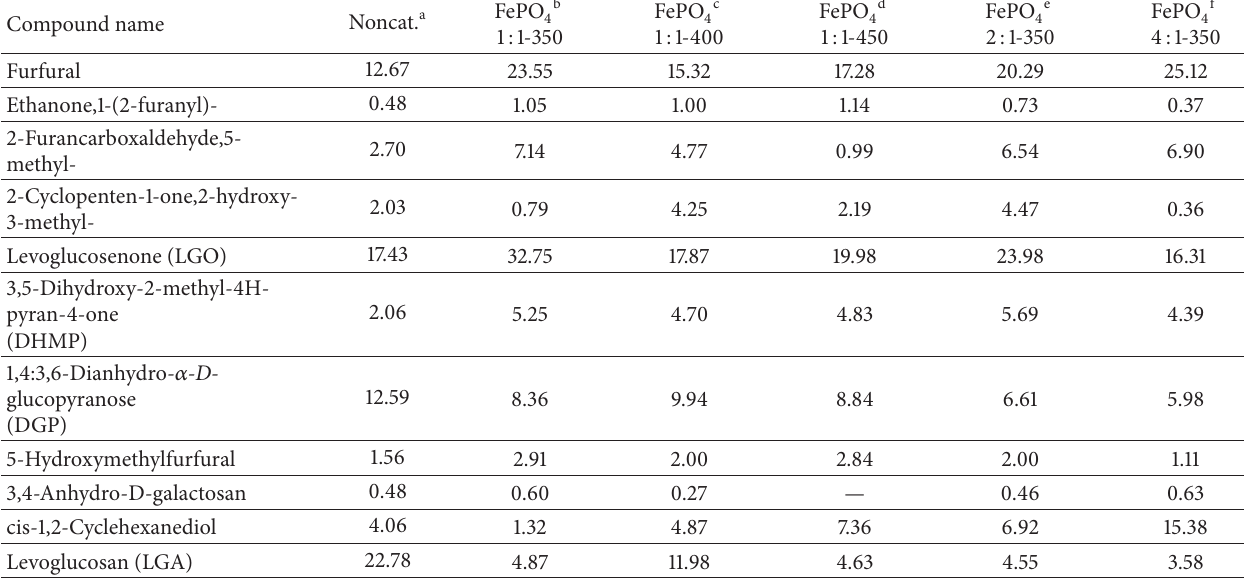
Table 5: The component analysis of the biooils produced from noncatalytic and catalytic pyrolysis of cellulose with FePO 4 (peak area% in the